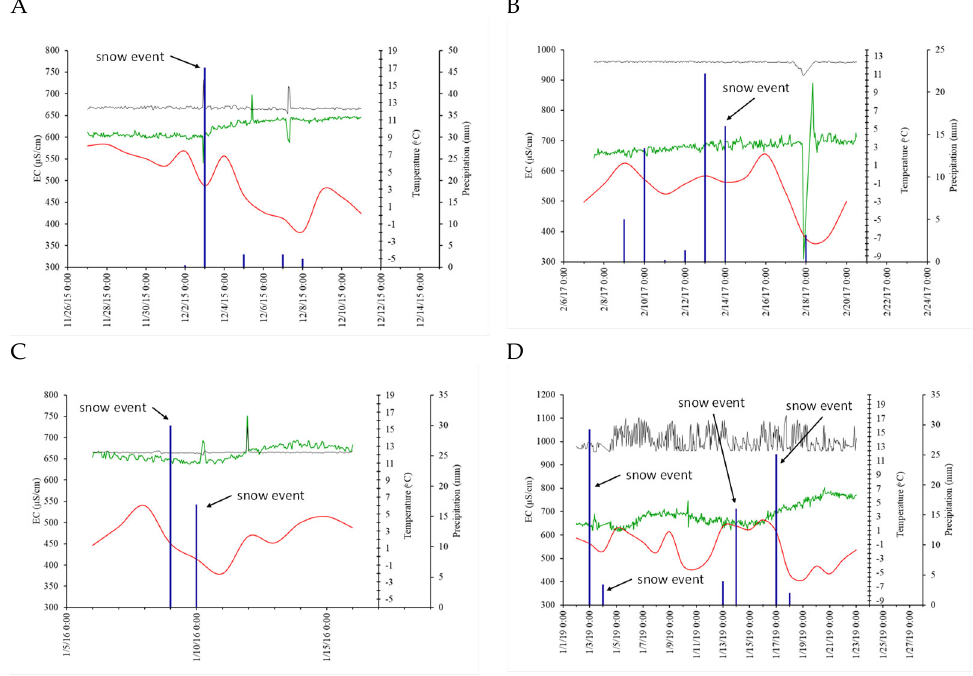
Figure 7. The impact of road ‐ deicing campaigns on groundwater in the BH ‐ 1 (blue bars represent the precipitation events; red, green, and black lines are daily average air temperature, groundwater EC, and groundwater temperature, respectively): ( A ) single snow event in the year 2015; ( B ) single snow event in the year 2017; ( C ) multiple snow events in the year 2016; ( D ) multiple snow events in the year 2019.